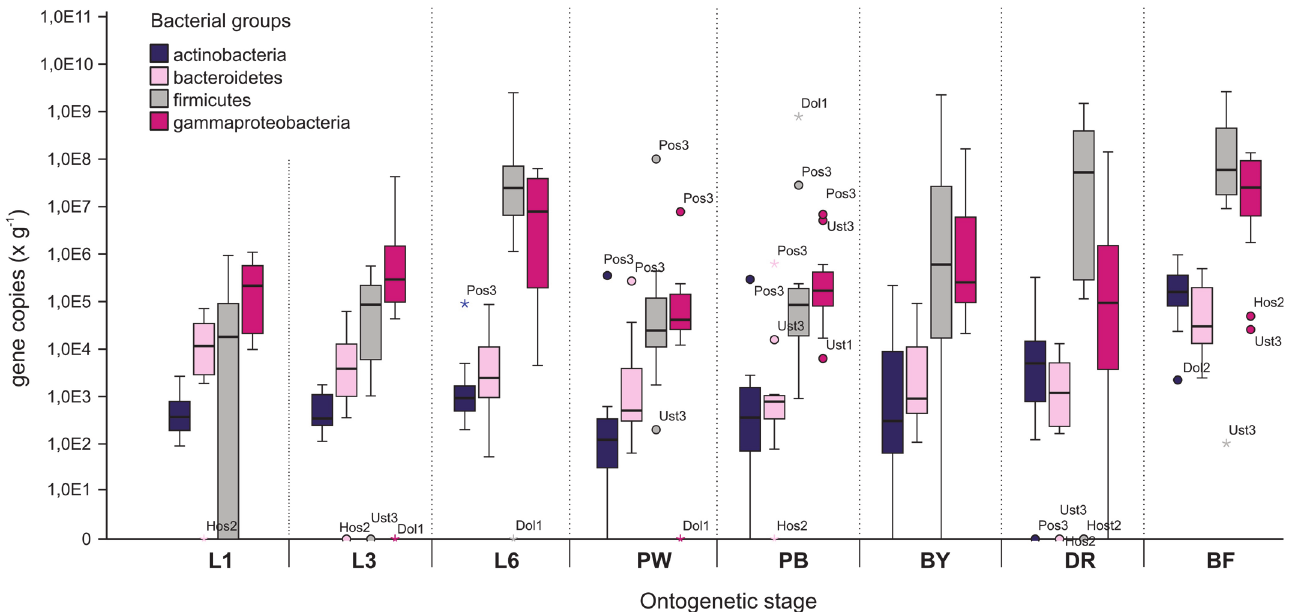
Fig 4. Boxplot of quantitative real-time PCR (qRT-PCR) data of the abundance of selected bacterial groups in pooled samples of total gastrointestinal tract of each honey bee ontogenetic stage. The Y axis shows log-transformed copies of the 16S rRNA gene per gram of honey bee gastrointestinal tract. Boxes show pooled data from 4 locations and 3 hives at each location. 1-, 3- and 6-day old larvae (L1, L3 and L6, respectively), white and black pupae (PW, PB), young bees, drones and flying bees (BY, DR and BF, respectively). The codes of the outliers refer to the location (Pos: Postrizin, Hos: Hostice, Ust: Ustrasice) and colony number (1, 2, 3).